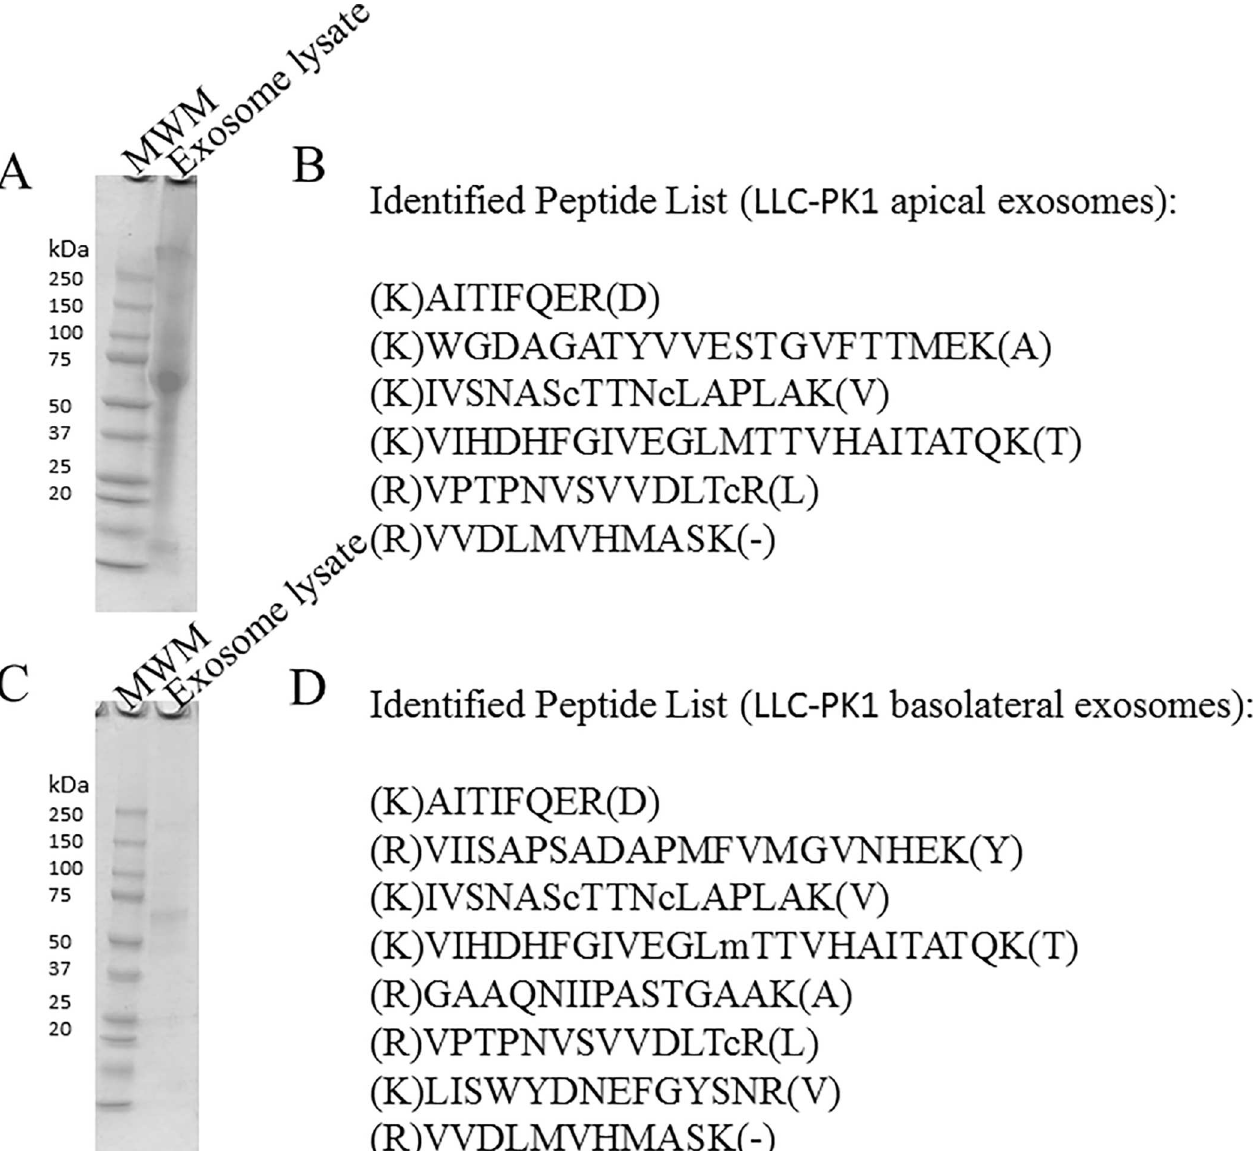
Fig 2. Coomassie blue–stained sodium dodecyl sulphate-polyacrylamidegel electrophoresis analysis (A) and mass spectrometry analysis(B) of lysed exosomes isolated from conditionedmedia in the apical compartment of LLC-PK1 cells. Coomassieblue–stainedsodium dodecyl sulphate- polyacrylamide gel electrophoresis analysis (C) and mass spectrometry analysis (D) of lysed exosomes isolated from conditioned media in the basolateralcompartment of LLC-PK1 cells. Molecular weight markers (MWM) are shown in the first lane. Peptides listed in (B) and (D) are signature peptides corresponding to